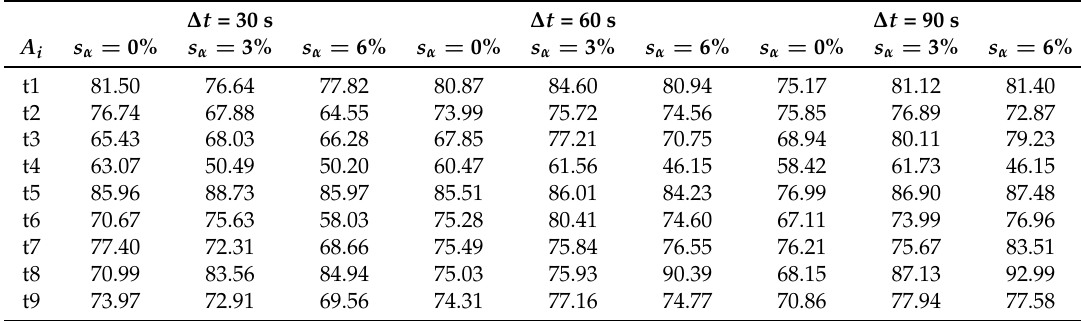
Table 3. Detailed values of metric F1-sc for each activity, duration of time-slot ∆ t and relevance factor s α